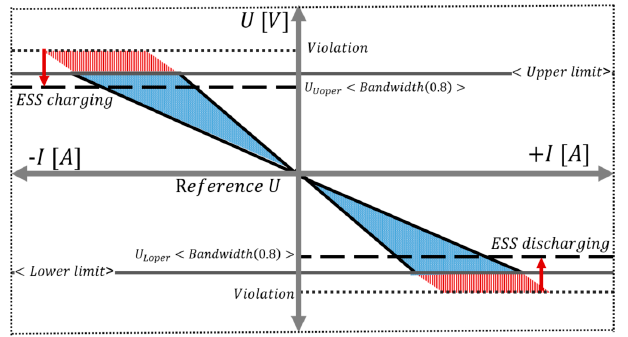
Figure 7. Concept for electric vehicle infrastructure stabilization (EVI)-algorithm by an ESS.